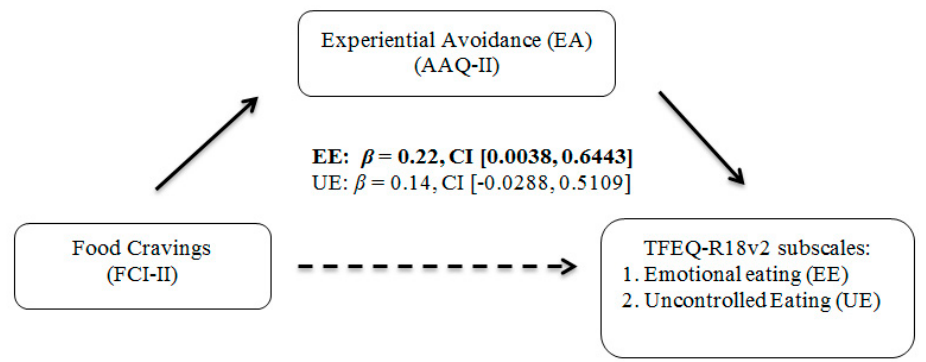
Figure 1. Mediation Analyses Examining EA, food cravings, Emotional Eating, and Uncontrolled Eating among Late Adolescents (Hypothesis 1 and 2). Note. Bootstrapping (with 1000 samples) was used in all mediations. 95% confidence intervals (CI) were employed. If the values between the lower and upper CI do not contain zero, then the mediation is significant. Bolded values indicate significant mediation.